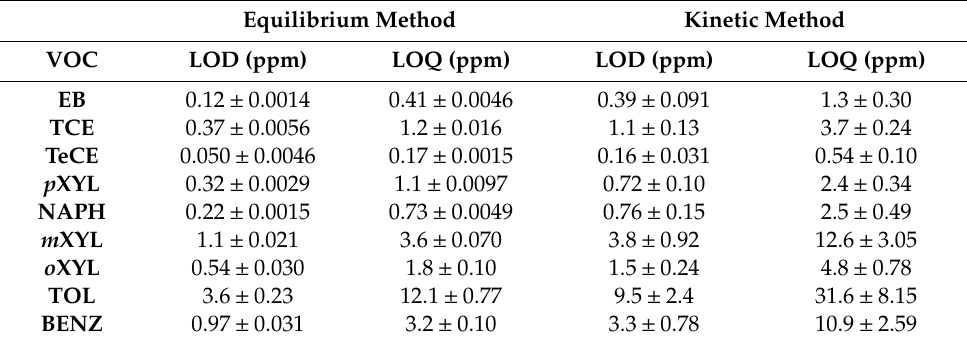
Table 5. Comparison of detection (LOD) and quantification limit (LOQ) obtained using the equilibrium method and the kinetic